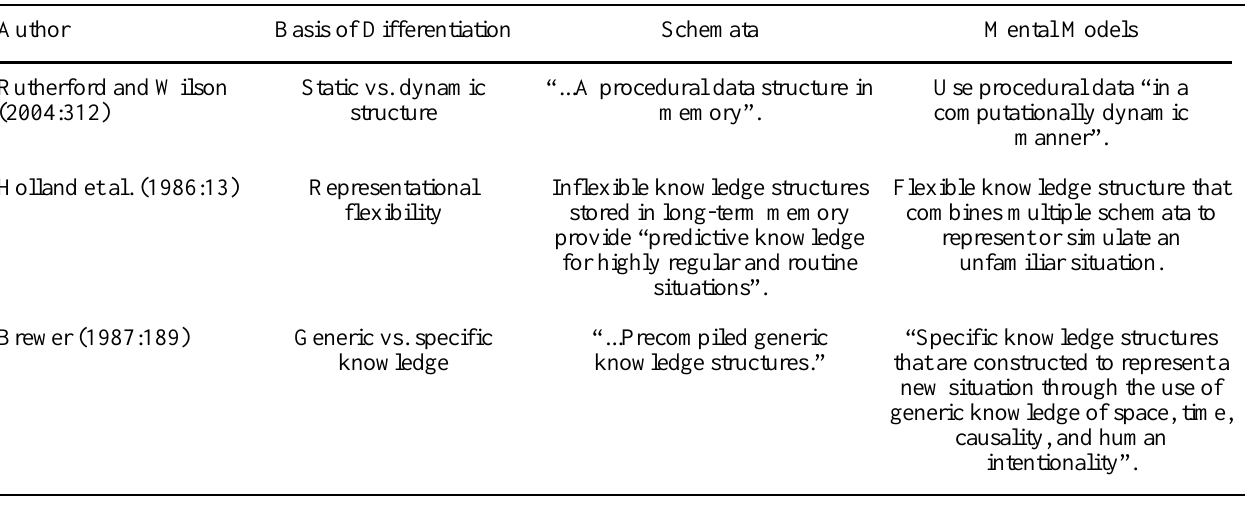
Table 1. Differences between mental models and schemata.